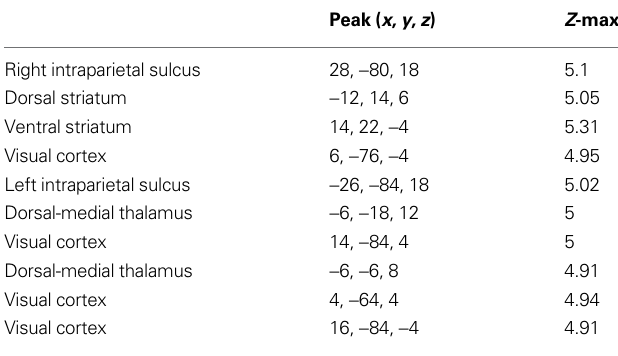
Table 1 | Self, Gain $4 > Gain $0.